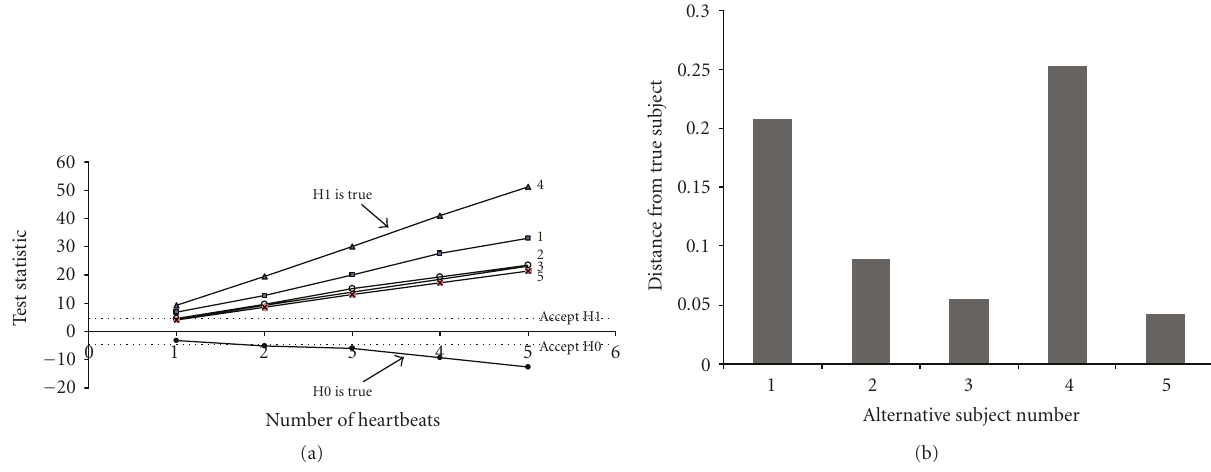
Figure 8: Example of a sequential procedure. (a) Sequential test statistic for a single declared identity when H 0 is true and for five imposters. (b) The distance of the declared identity to the five imposters.